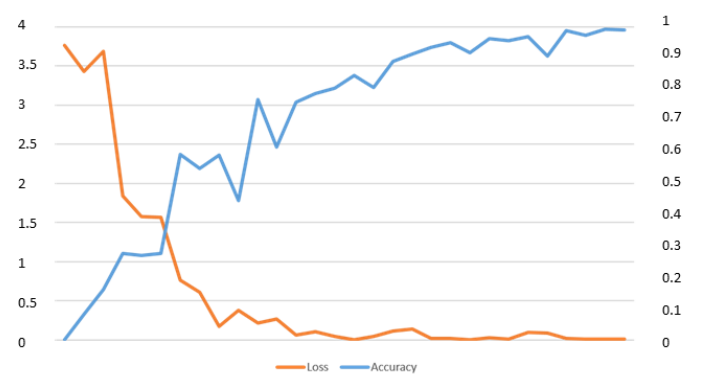
Figure 13. ResNet50 training accuracy and loss for the traffic sign classification